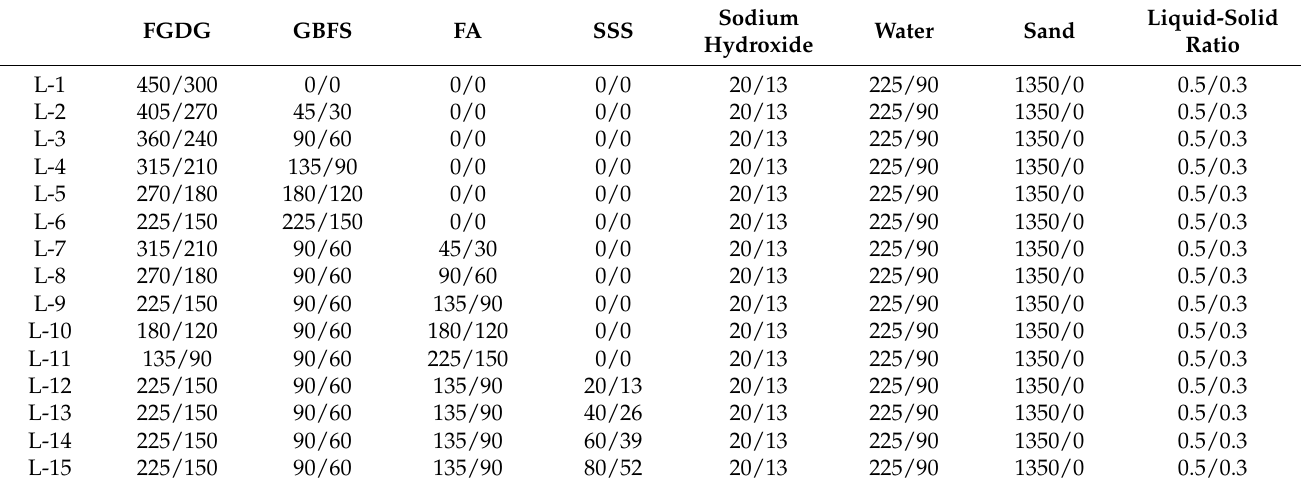
Table 2. Mix proportion of